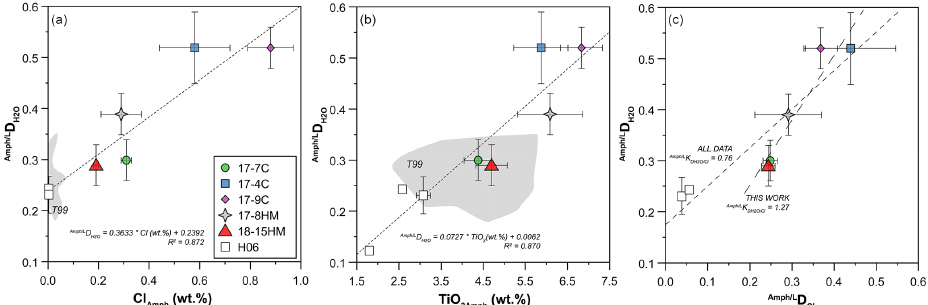
Figure 8. Correlation between Amph / L D H and Cl (a) and TiO 2 (b) contents (wt%) in amphibole. H06: data from Hauri et al. (2006); T99: 2 O data from Tiepolo (1999). The diagram in (c) shows the correlation between Amph / L D H ( Amph / L K D H ). Amph / L K D H obtained from this work is 1.27, although it becomes lower than unity considering all data (this study 2 O / Cl 2 O / Cl and data from Hauri et al.,